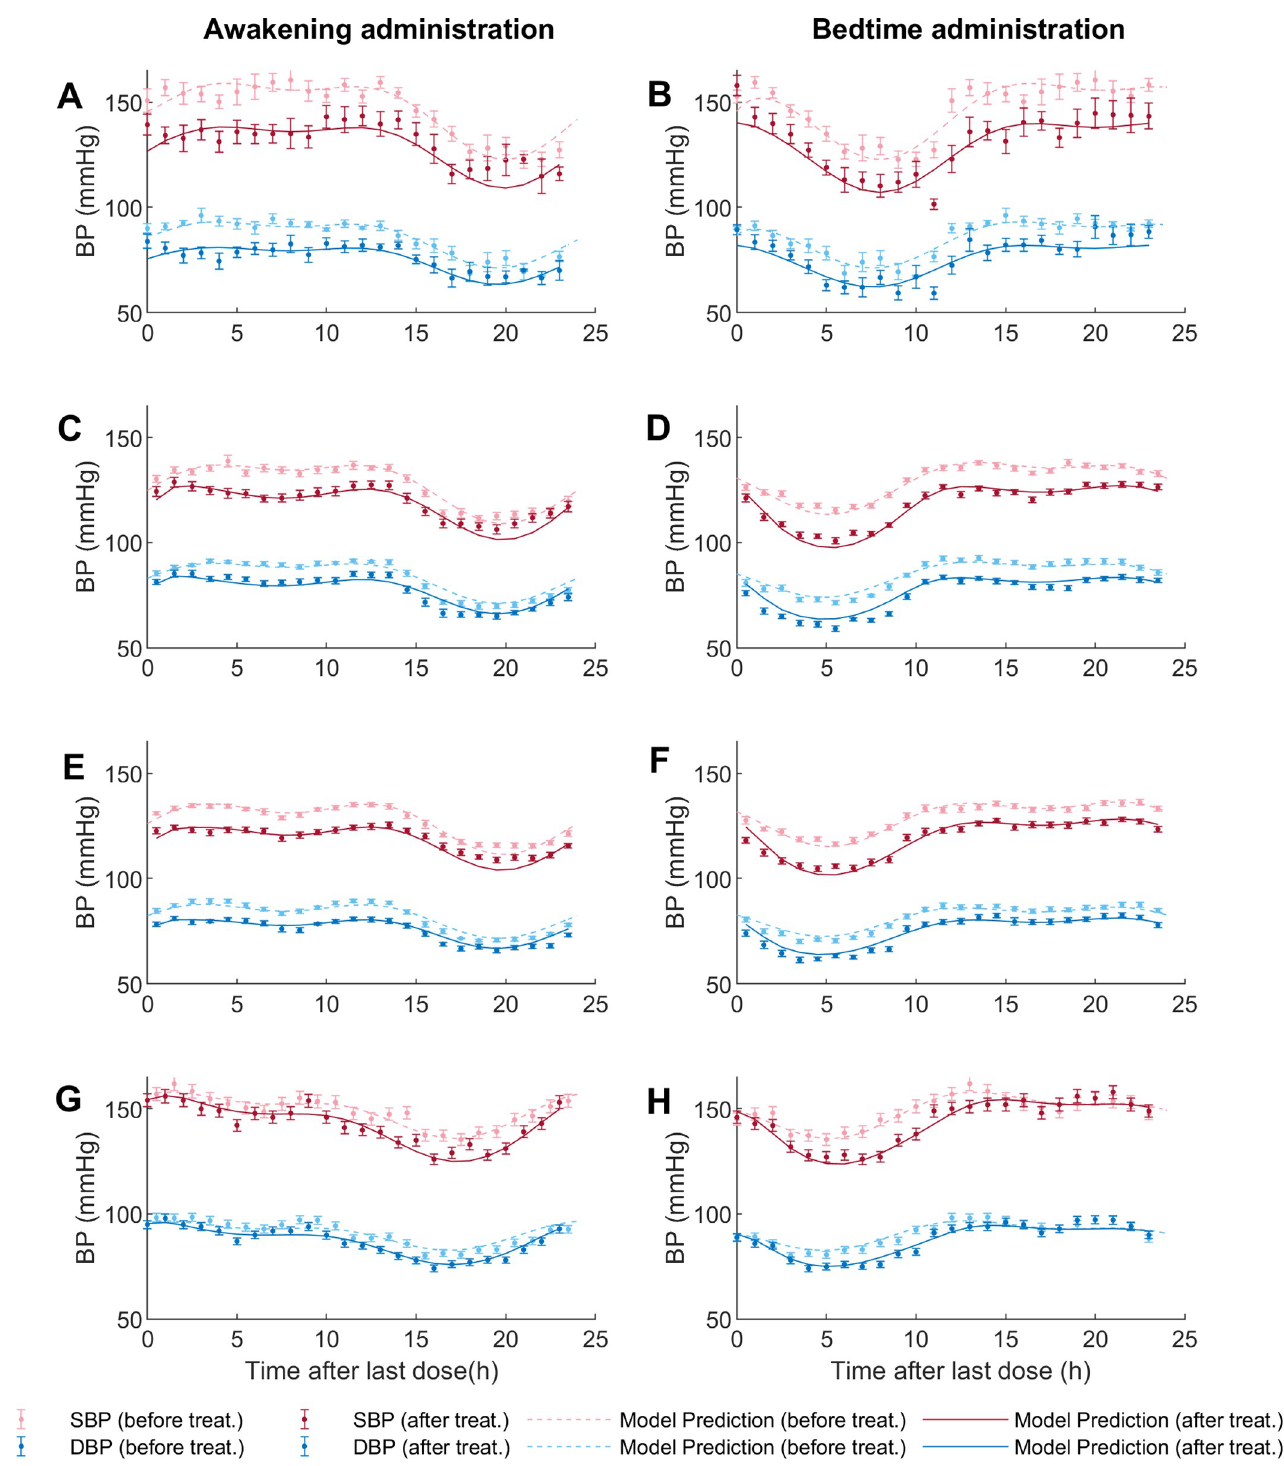
Fig 3. Model fitting to the experimental data for prodrug models. The figures on the left correspond to awakening/morning administration and on the right to bedtime/evening administration. Each figure shows data with their respective standard errors (SE) for SBP before treatment (light red dots) and DBP (light blue dots), and for SBP after treatment (dark red dots), DBP (dark blue dots). The dotted line represents the model prediction before treatment, and the solid line represents the model prediction of each model after the last dose. Fig 3A and 3B, enalapril; Fig 3C and 3D, ramipril; Fig 3E and 3F, spirapril; Fig 3G and 3H,